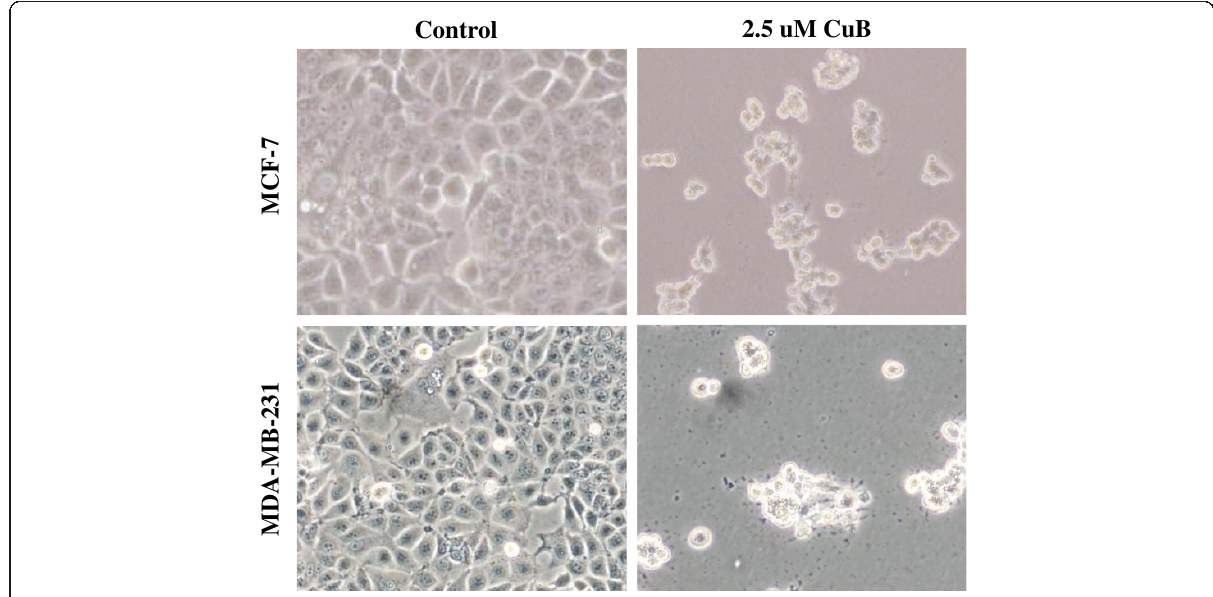
Figure 7 Morphological changes by cucurbitacin B treatment of breast cancer cells. MCF-7 and MDA-MB-231 cells were treated with 2.5 μ M cucurbitacin B for 24 hr, and the cells were visualized under phase-contrast microscopy to investigate the morphological alteration. Shrinkage and rounding of the cell shape were observed in both cell